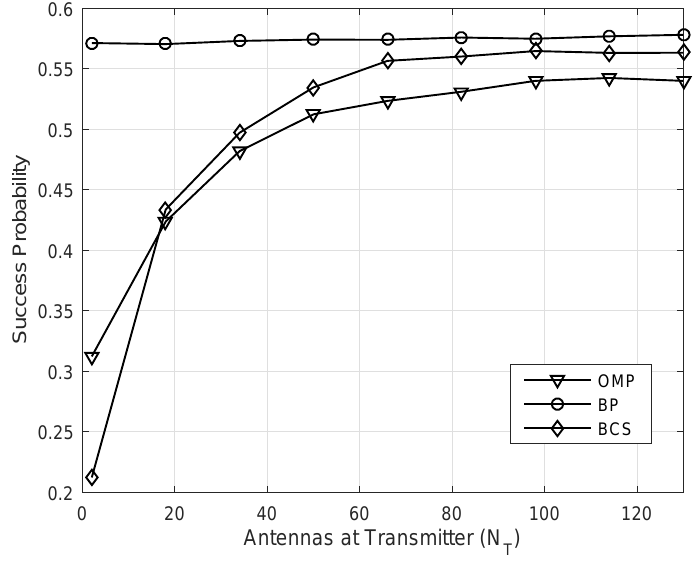
Figure 7. Success probability of channel estimation versus the number of antennas ( N T ) with received = 4, γ = − 10 dB, sparseness L = 5 and pilot symbol frames M = 16 SNR = 10 dB, N R = 4, N R th RF and without hardware